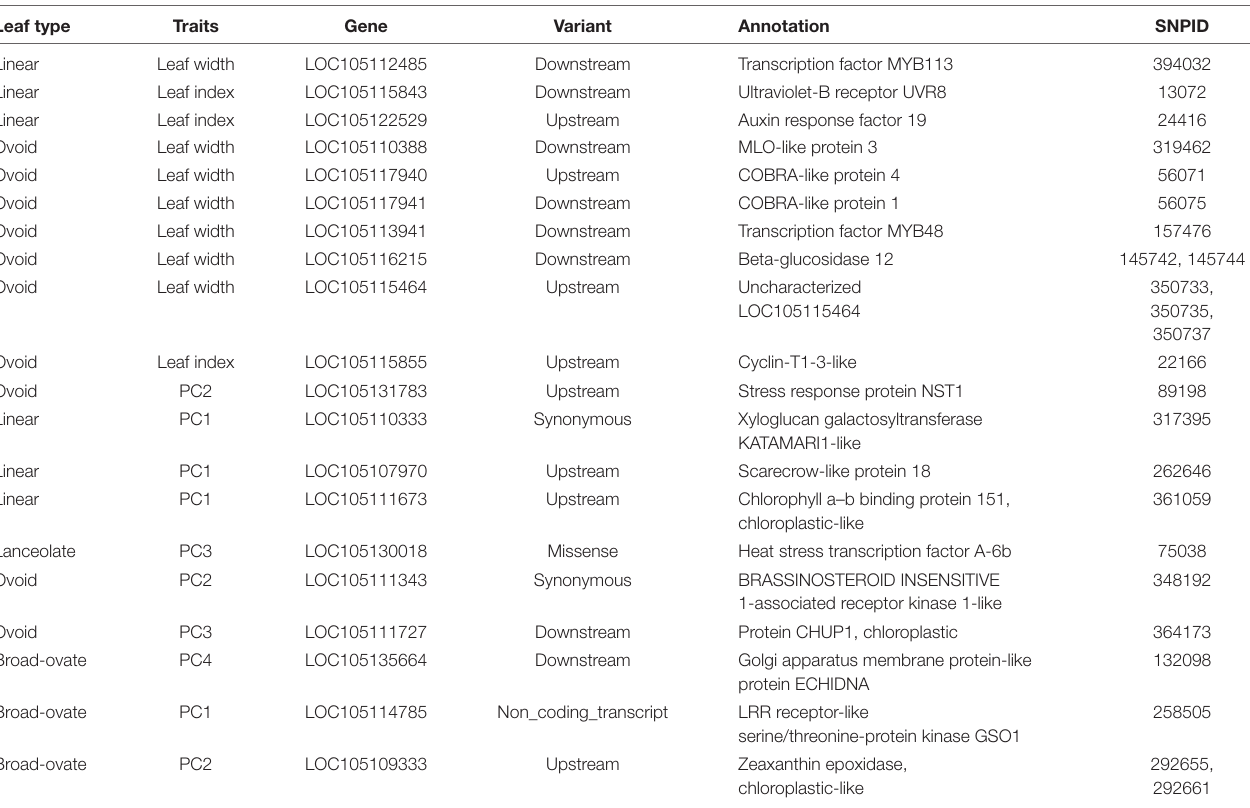
TABLE 1 | Candidate genes identified according to significant SNPs for the different traits based on